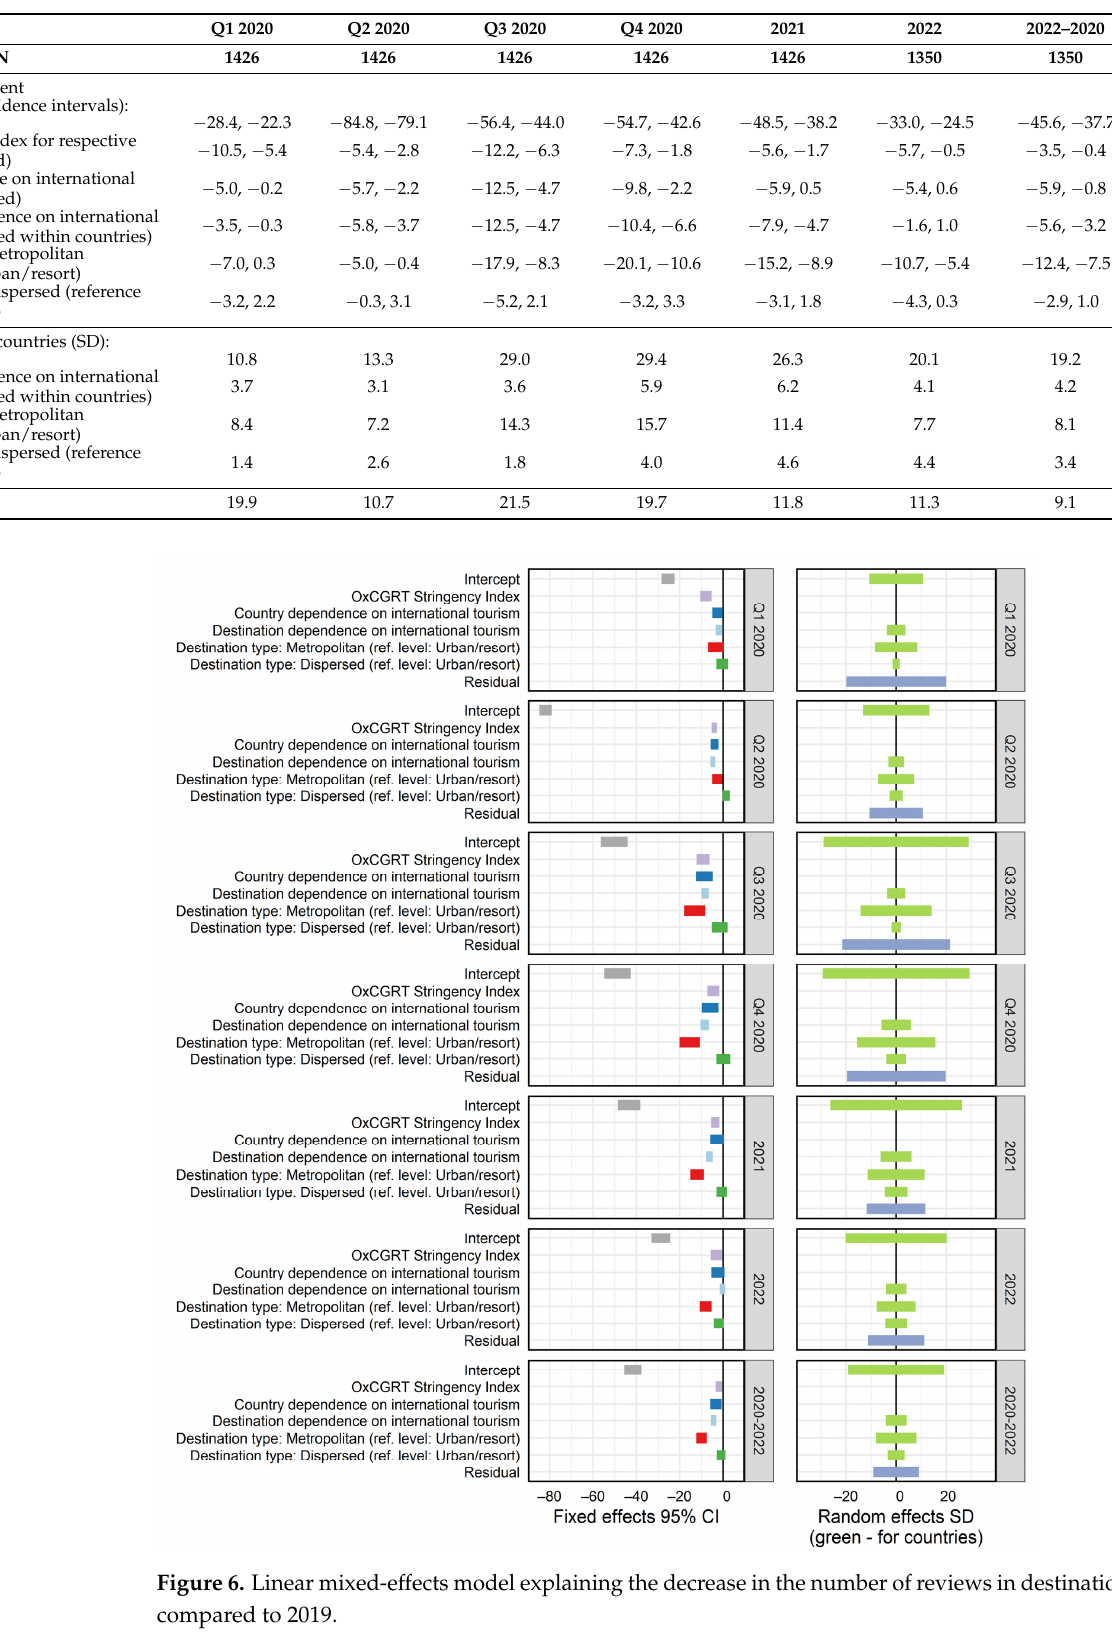
Table 8. Results of the linear mixed-effects models explaining the decrease in the number of reviews in destinations compared to 2019.